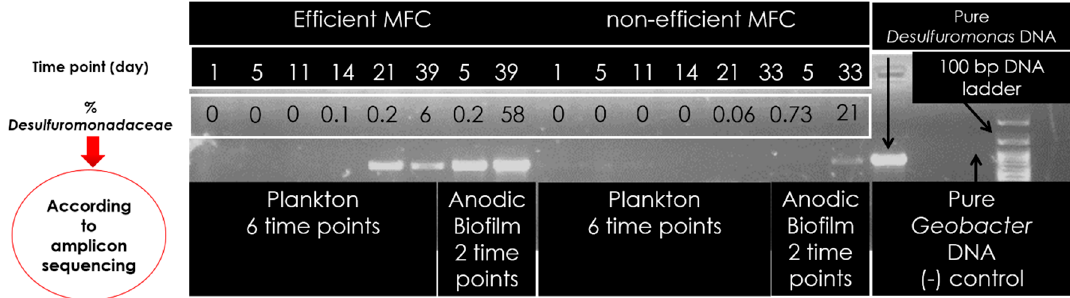
Figure 3. PCR products obtained with the specific Desulfuromonas dechlorinator ‐ targeted primers of representative MFCs as indicated on the gel for experiments 2015 and 2016. Desulfuromonas pure DNA was purchased from DSMZ for Desulfuromonas acetexigens, DSM 1397 and performed as a positive control. First lane from the left is a 100 bp size ladder.